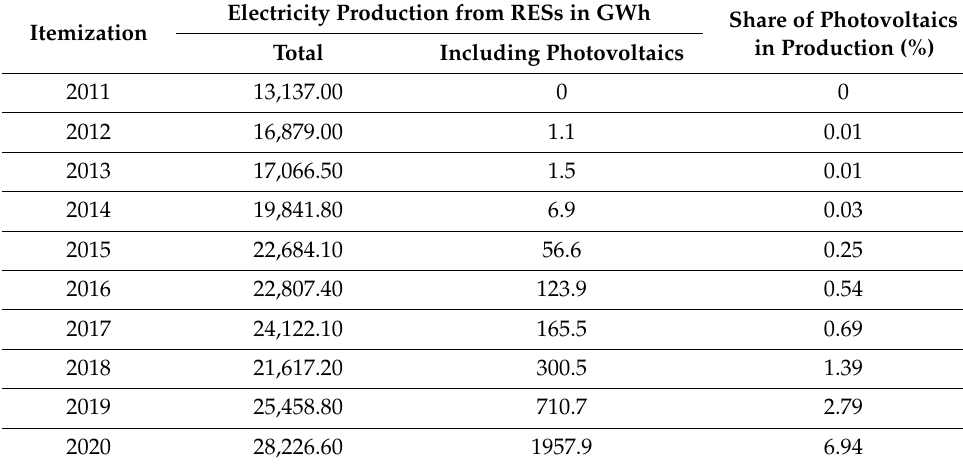
Table 1. Electricity production from RESs between 2011 and 2020 in Poland.